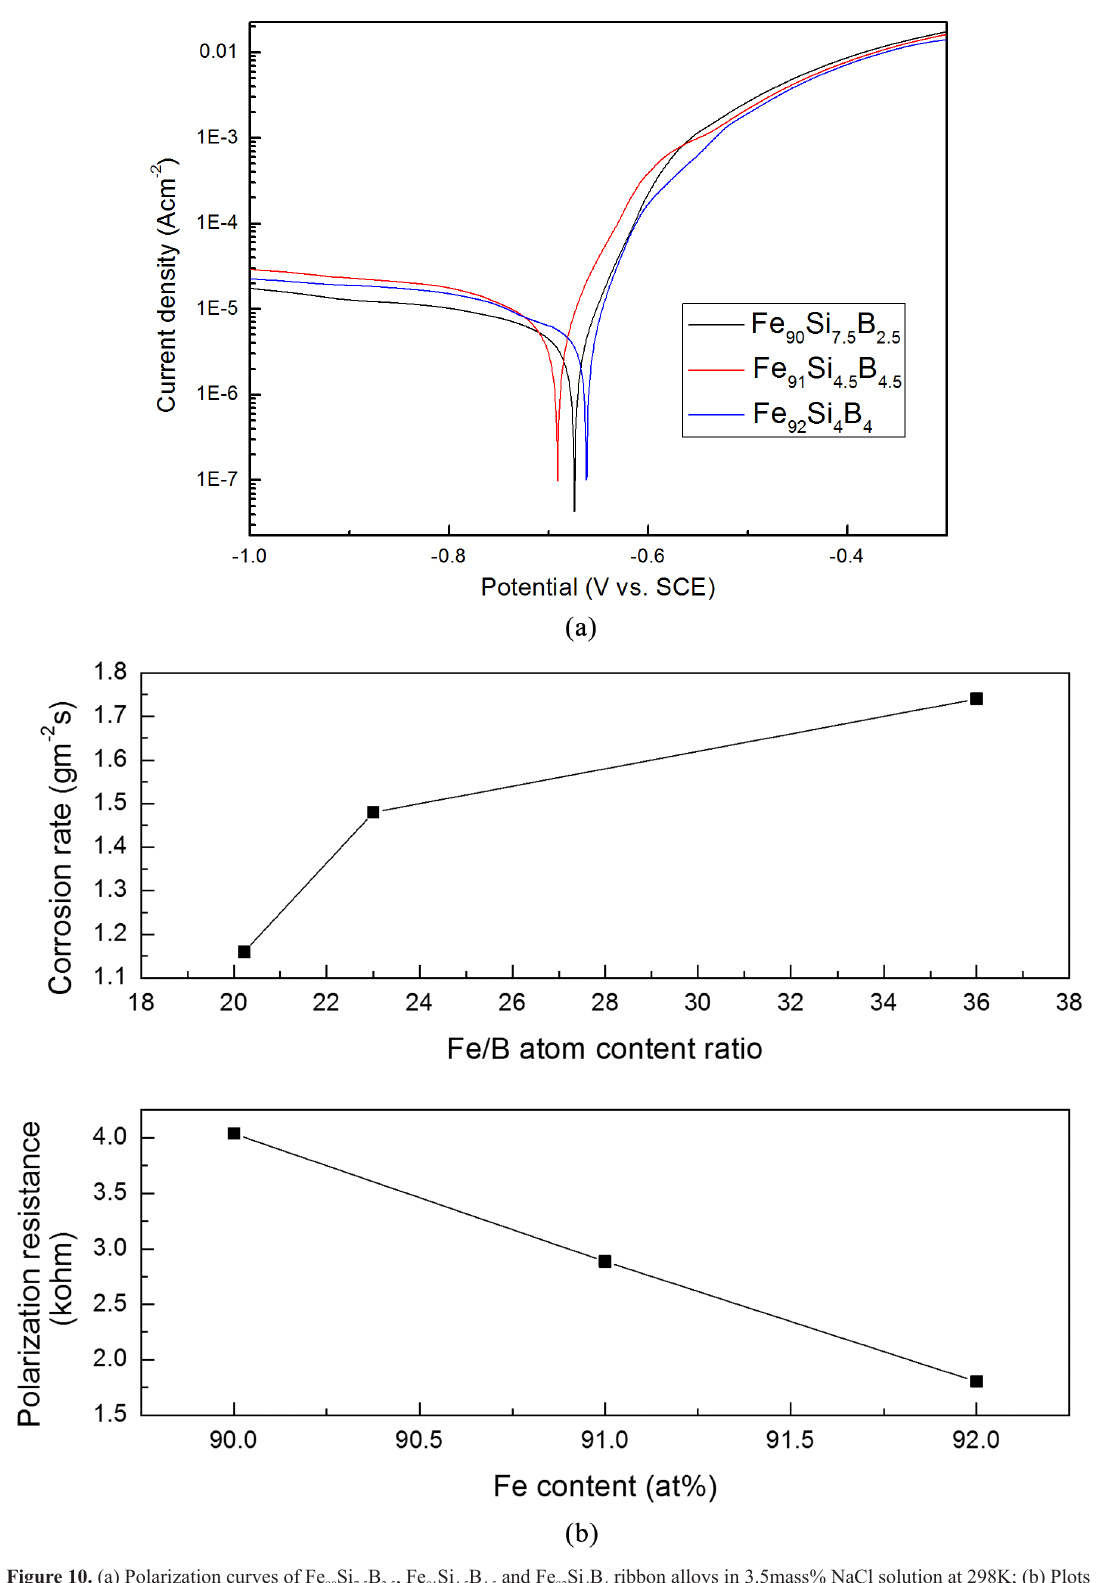
Figure 10. (a) Polarization curves of Fe of corrosion rate – Fe/B atom content ratio vs. Polarization resistance – Fe